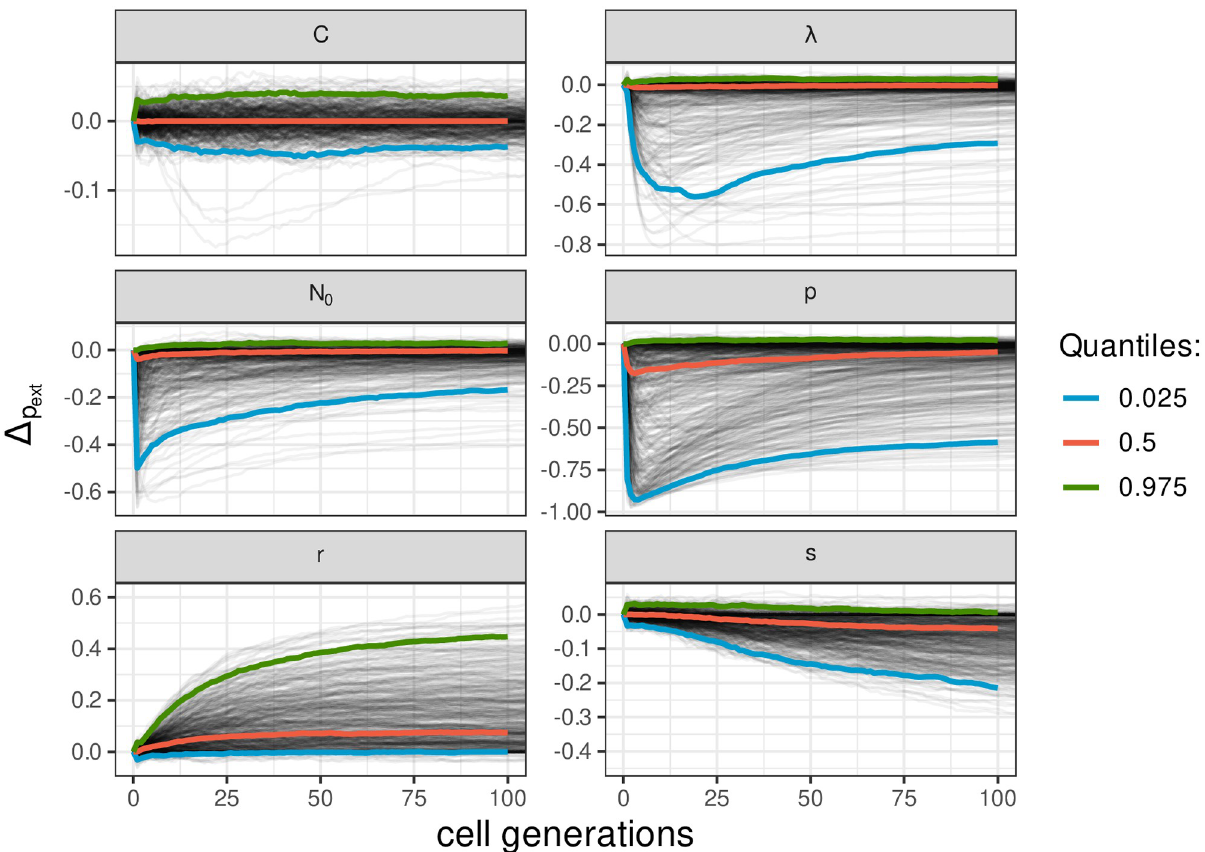
Fig 1. Difference in the cumulative probability of extinction for two sets of parameters that only differ by one value. On each panel, the title indicates which parameter varies between the two sets. In each of this panel, we subtract the probability of extinction for the lowest of the two varying parameters to the probability of extinction of the highest of the two. We find consistent results as theory prediction: the probability of extinction decreases with λ , p , s , N 0 and increase with r . The viral capacity in cell ( C ), has little to no effect on the probability of infection. Line colors show the median (in red) and the first and third quartiles (in blue and